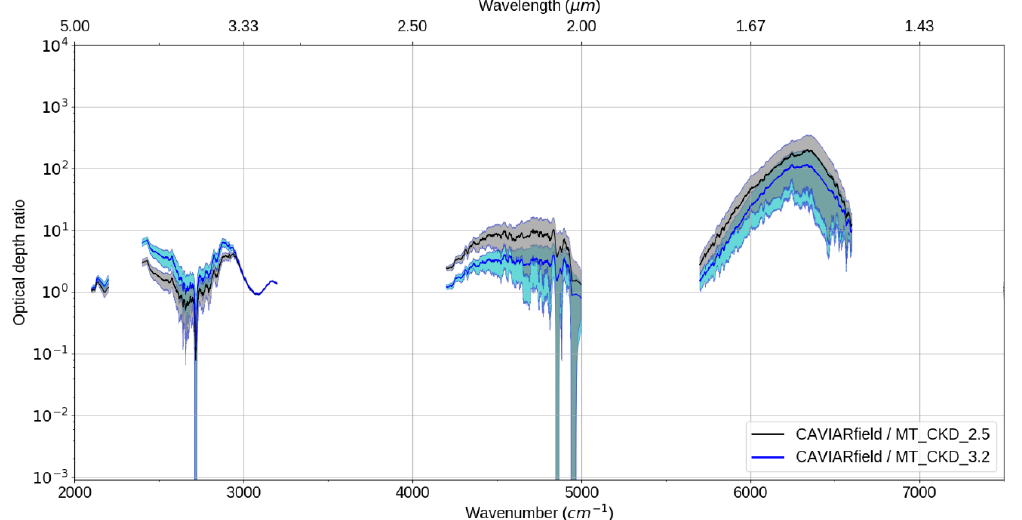
Figure 10. Ratio of Langley-derived CAVIAR-field continuum optical depth divided by MT_CKD optical depth (for two different versions of MT_CKD) in the 2.1 and 1.6µm atmospheric windows for 18 September 2008. Uncertainties (shaded regions) shown at k =